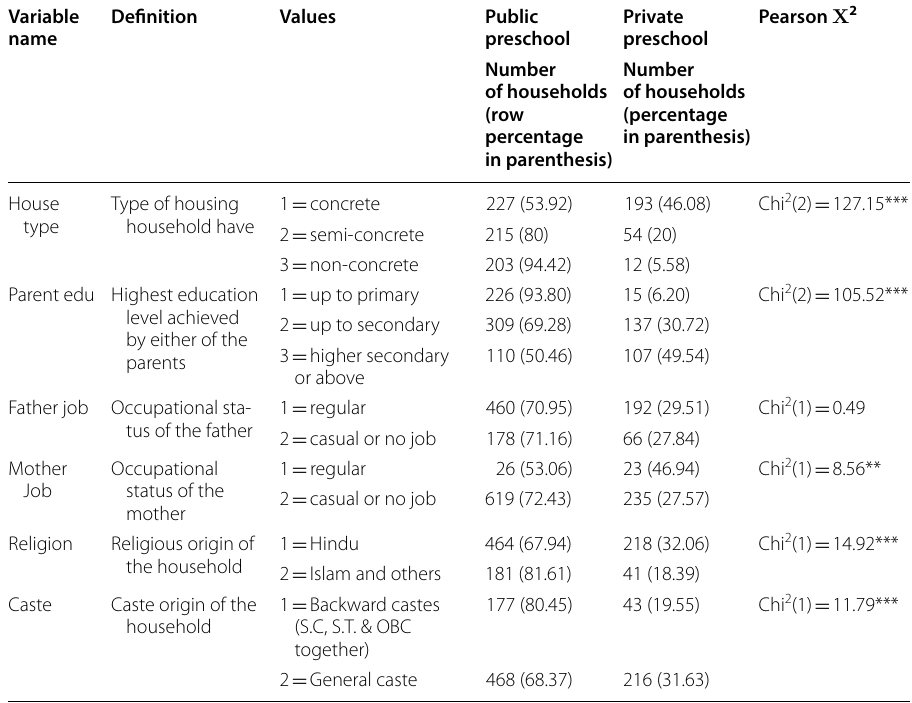
Table 2 Social status and type of preschool